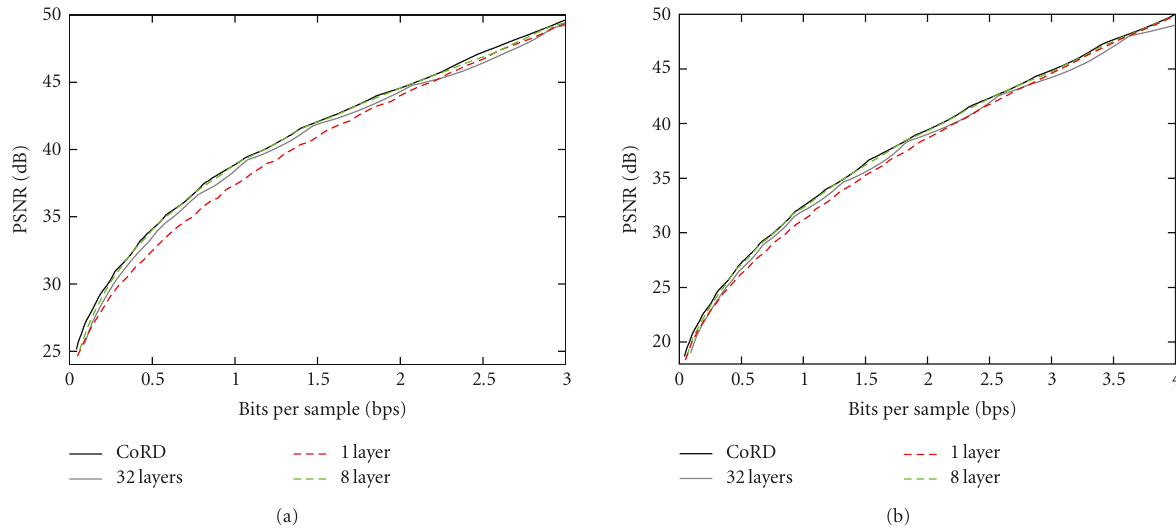
Figure 9: Comparison of BWLT with state-of-the-art methods in a transcoding application. (a) “Portrait” image. (b) “Cafeteria” image.